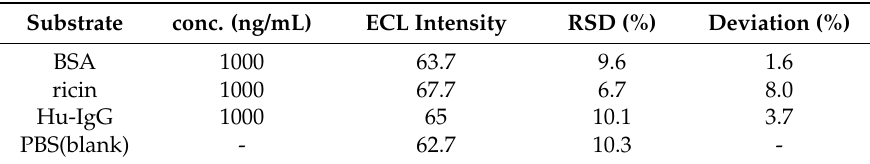
Table 1. Determination of substrate specificity ( n = 3).